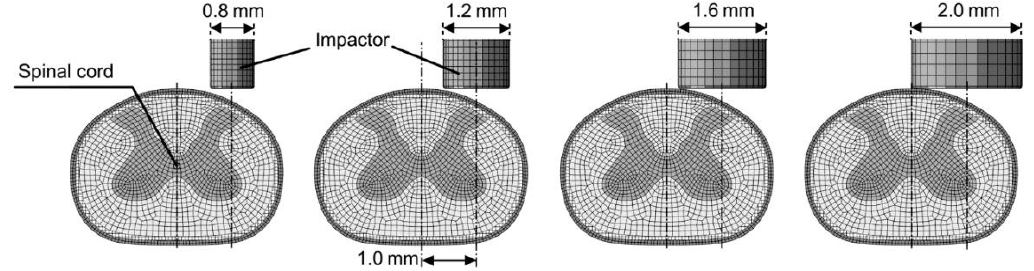
Figure 2. Spinal cord with four different impactors which were moved 1.0 mm to the right side of the midline, which was approximately centered over the right side of the spinal cord.